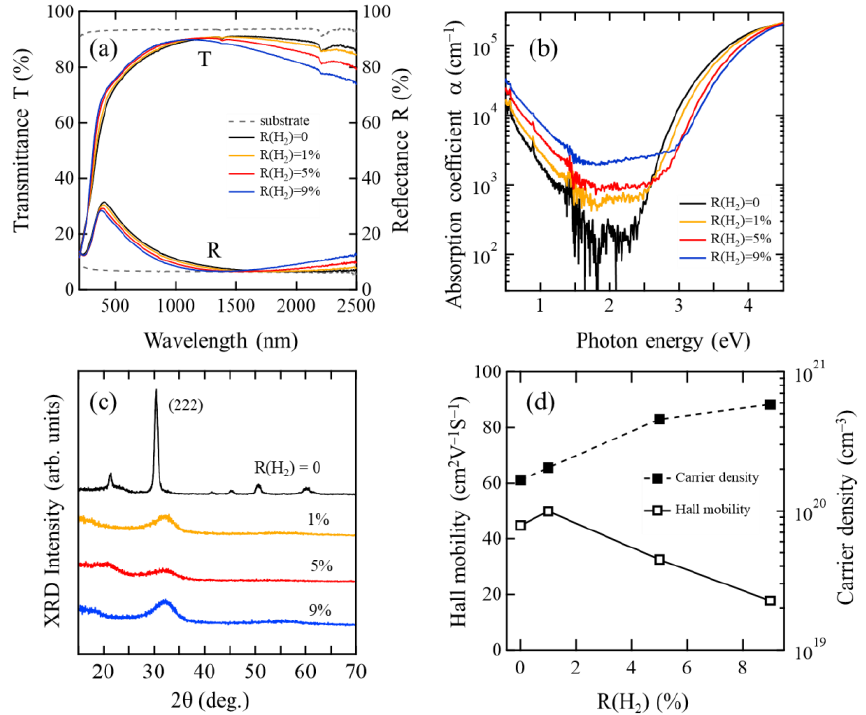
Figure 1. ( a ) Transmittance and reflectance, ( b ) absorption coefficient, ( c ) XRD spectra, and ( d ) Hall mobility and carrier density of as-deposited poly-InO x [R(H 2 ) = 0] and a-InO x :H [R(H 2 ) = 1, 5, 9%] films.